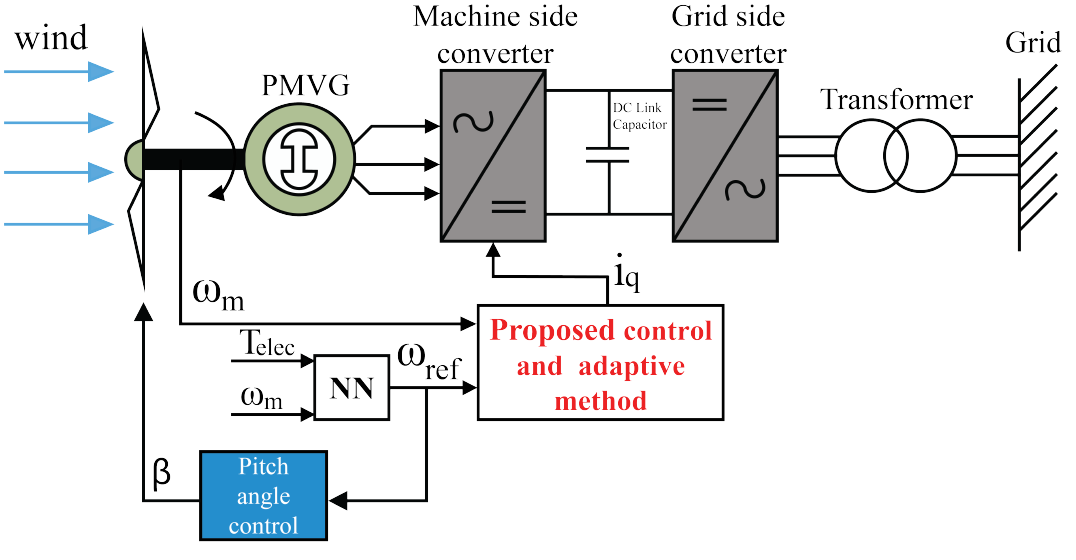
Figure 1. Basic topology of PMVG-based WECS with control